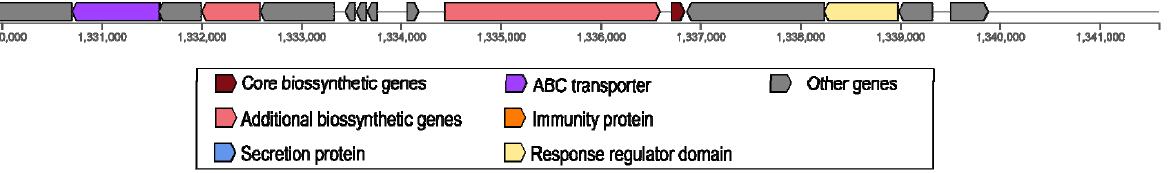
Figure 5. Schematic representation of biosynthetic gene clusters for bacteriocin production in the genomes of ruminal S. lutetiensis . The genomes were submitted to antiSMASH 5.0 analysis and the putative gene clusters for bacteriocin production were assembled using a local BLAST method and reference gene cluster. The arrows indicate the direction of transcription for each gene and the colors indicate gene function.